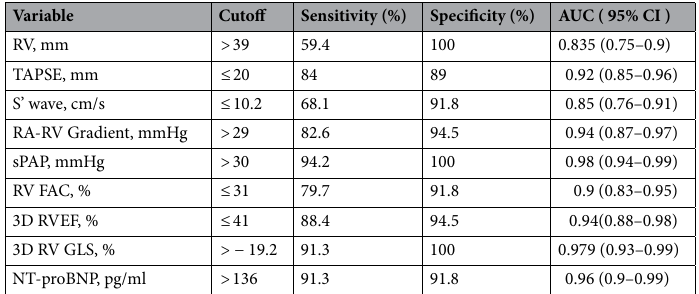
Table 3. ROC cutoff values predicting OSA.